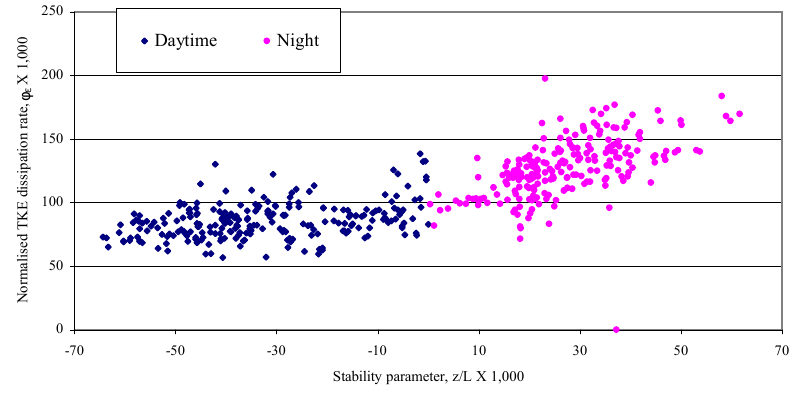
Experimental Spectrum Von Karman Spectrum Figure 9 :